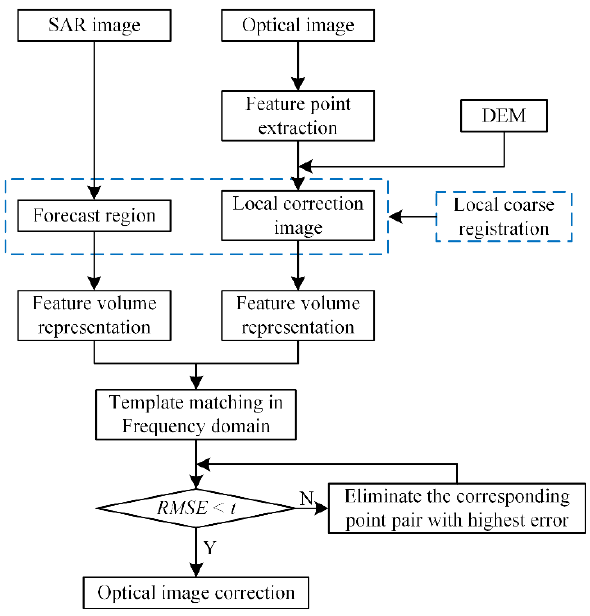
Figure 1. Flowchart of proposed method